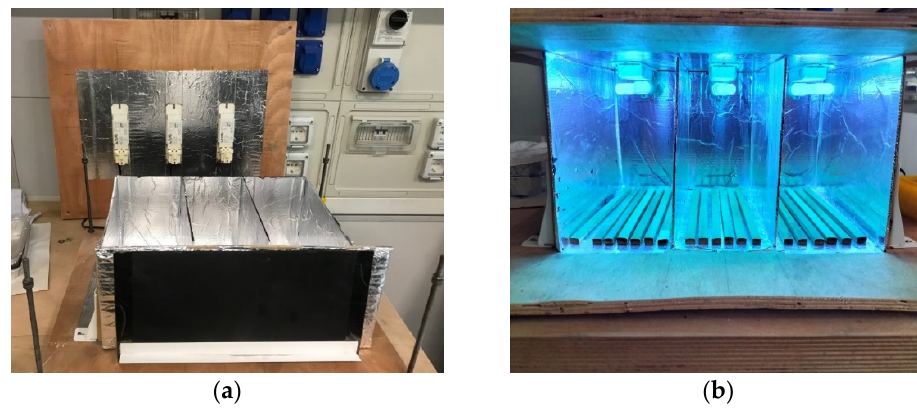
Figure 4. Box used for performing UV irradiation test before ( a ) and during ( b ) irradiation.